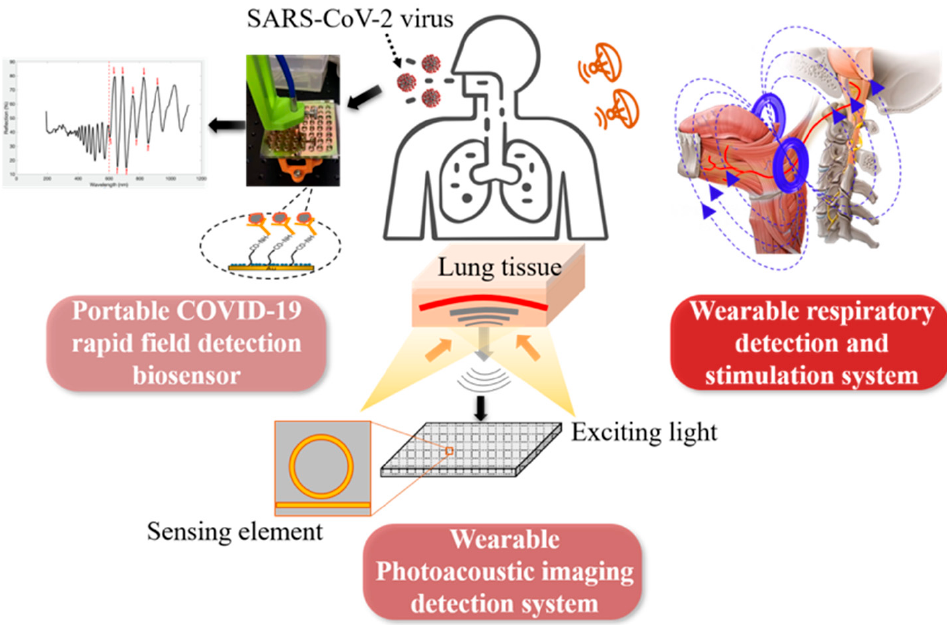
Figure 1. Proposed closed-loop solution for COVID-19, including three main parts: portable biosensor, wearable photoacoustic imaging, and breath detection and magnetic as well as electrical stim- ulation.